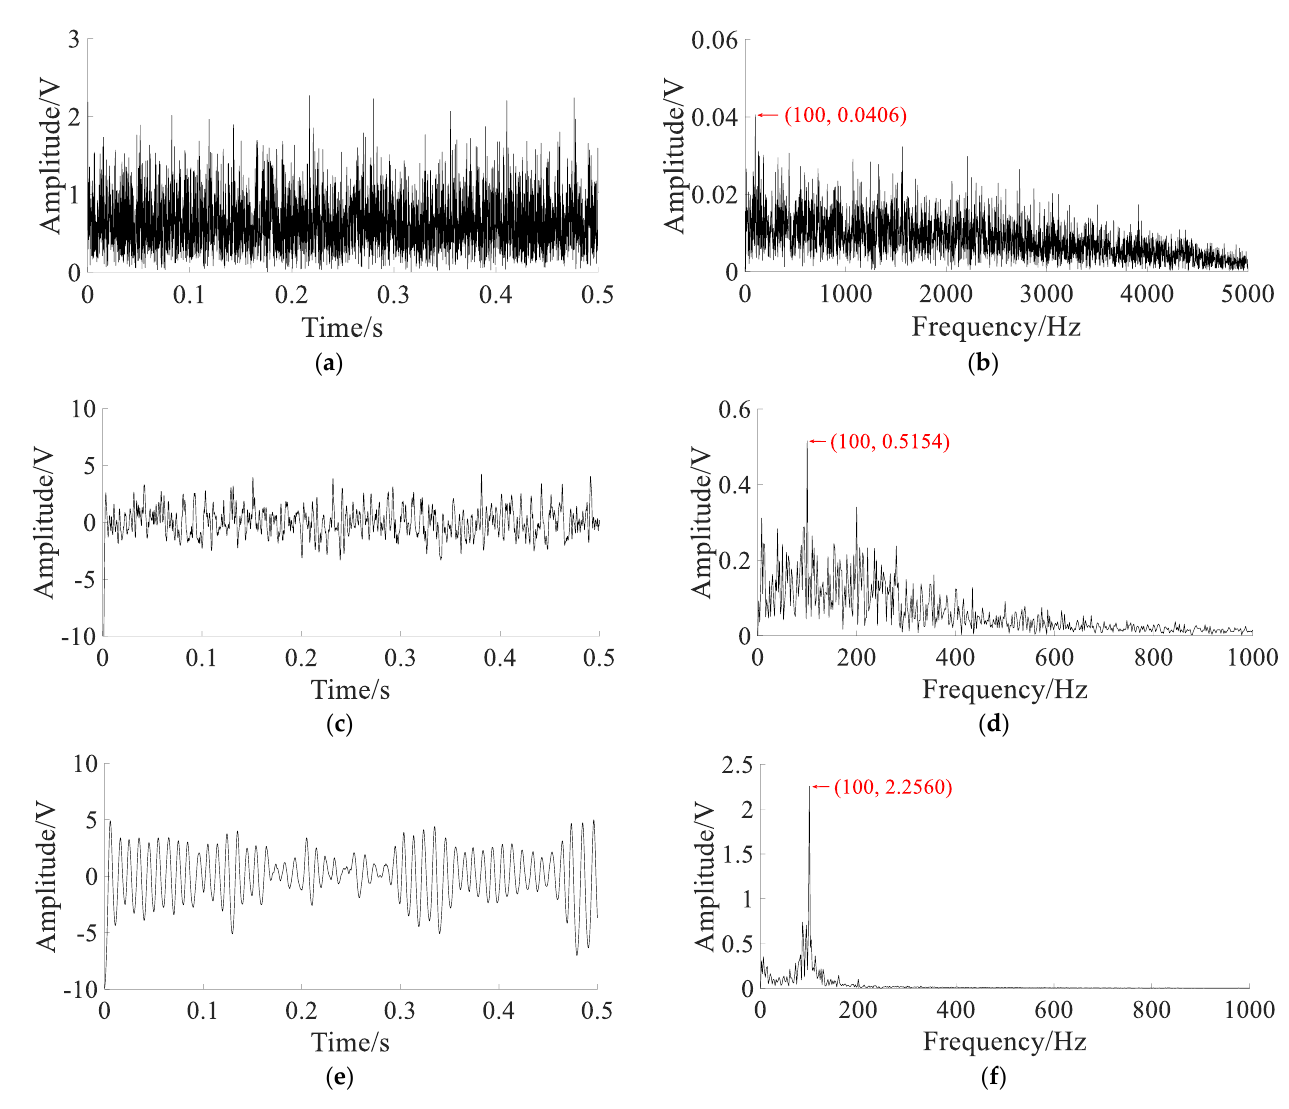
Figure 12. The results of with different methods: ( a ) Hilbert transform envelope demodulation signal; ( b ) Hilbert envelope spectrum; ( c ) output signal of SGST adaptive SR: a = 0.4547, b = 0.0012, m = 3000, γ = 0.3996; ( d ) output signal spectrum of SGST adaptive SR; ( e ) output signal of SAFRM adaptive SR: R = 3000, γ = 0.0112, ε = 0.2663; ( f ) output signal spectrum of SAFRM adaptive